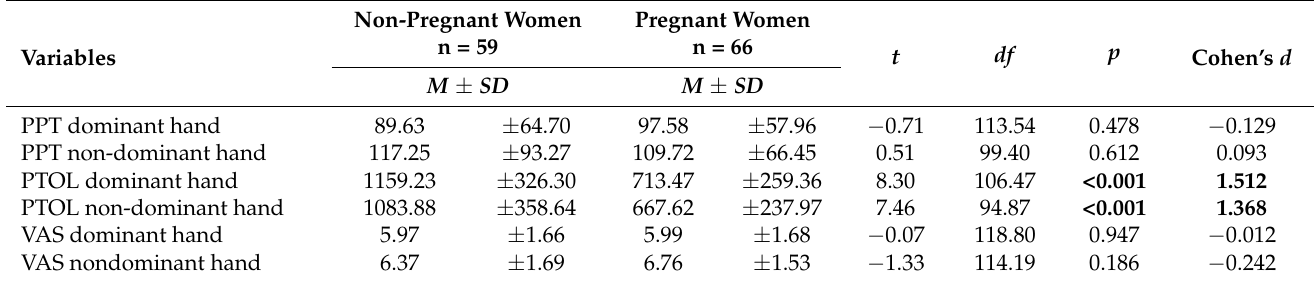
Table 1. Pain sensitivity indicators in pregnant and non-pregnant women.